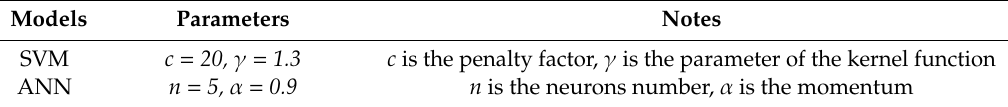
Table 6. The parameters of support vector machine (SVM) and artificial neural network (ANN) models. Models